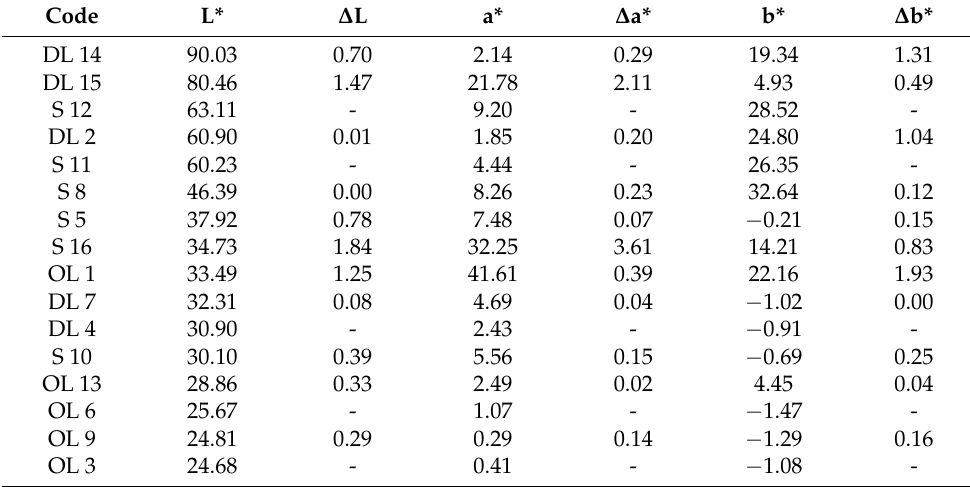
Table 8. Average color measurements of Red 2 sorted from largest to smallest L*.